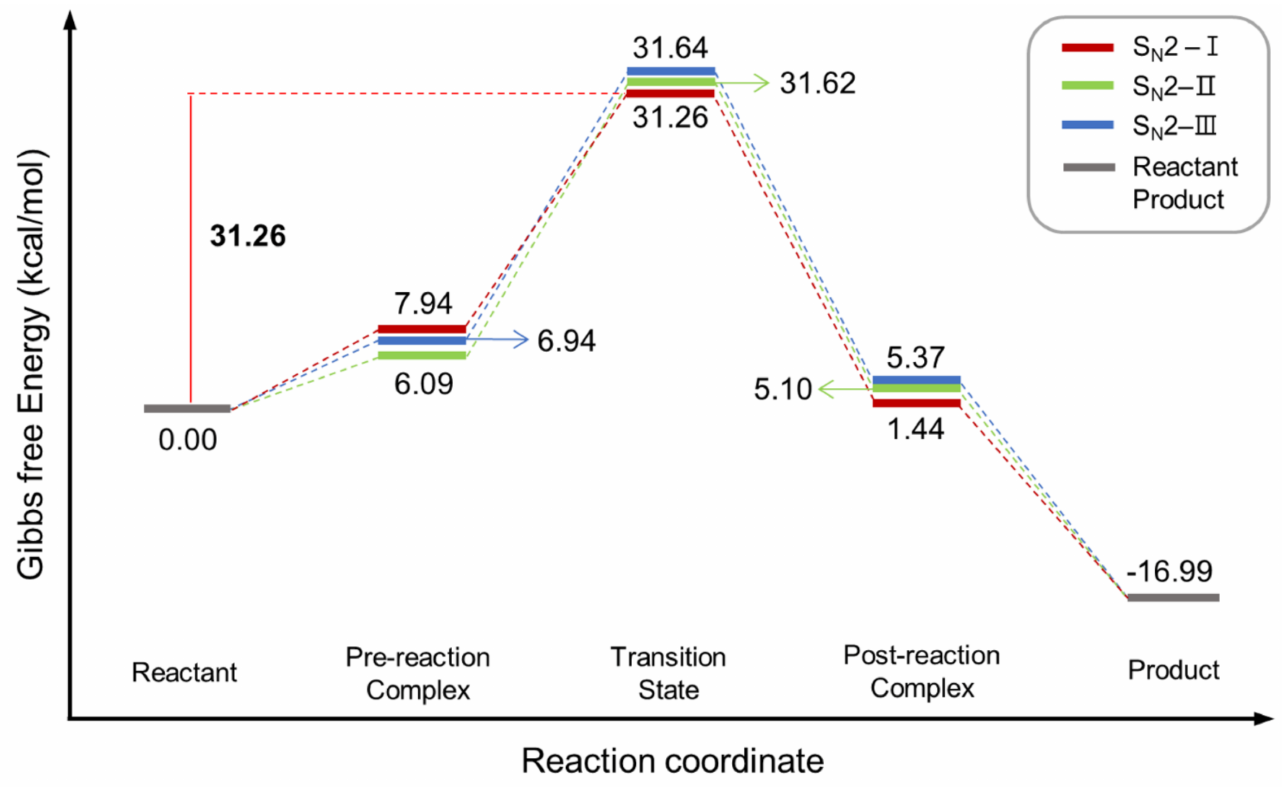
Figure 2. Energetics of 18 F-fluorination using TBMA- 18 F in CH 3